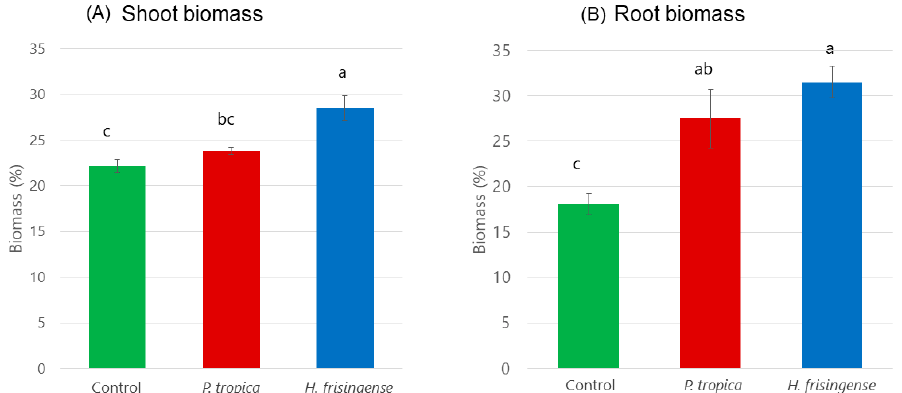
Figure 5. ( A ) Shoot and ( B) root biomass (%) of sorghum cultivar SRN-39 inoculated with Paraburkholderia tropica strain IAC/BECa 135 and Herbaspirillum frisingense strain IAC/BECa 152. The values are the means of replicates ( n = 6) ± (SE). For each parameter, letters in the same column compare means between treatments. Means followed by the same letter are not statistically different according to Duncan's test ( p <